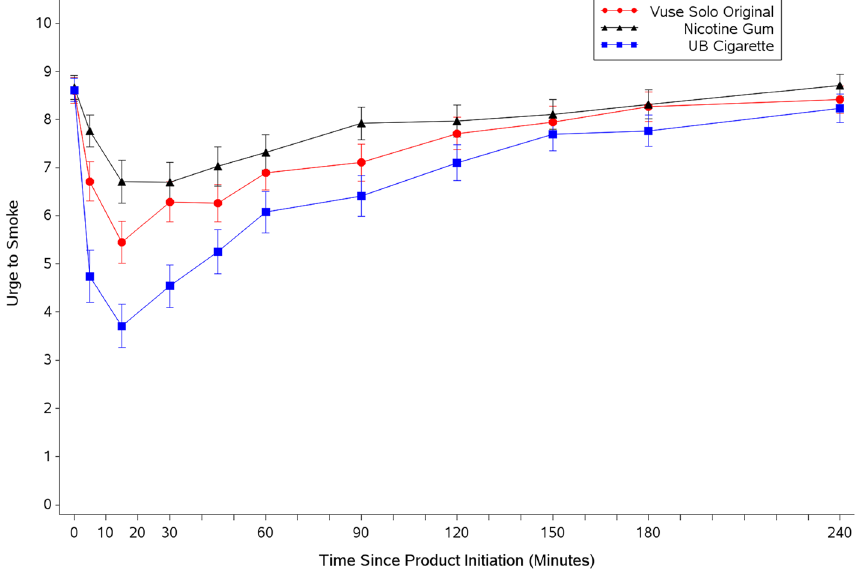
Figure 1. Arithmetic mean (SE) urge to smoke response profiles over four hours after initiation of product use. SE standard error, UB usual brand.